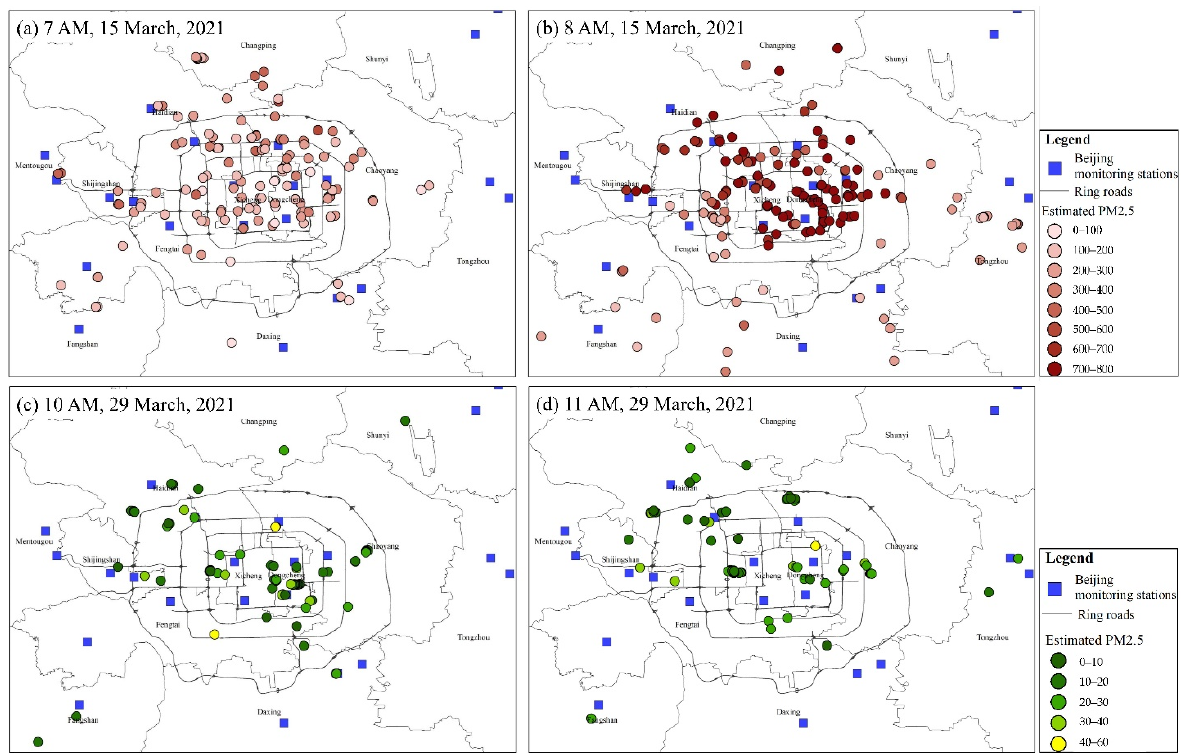
Figure 6. The estimated PM 2.5 concentrations using smartphone photographs crowdsourced from the Moji Weather application on 15 March 2021 ( a , b ) and 29 March 2021 ( c , d ).